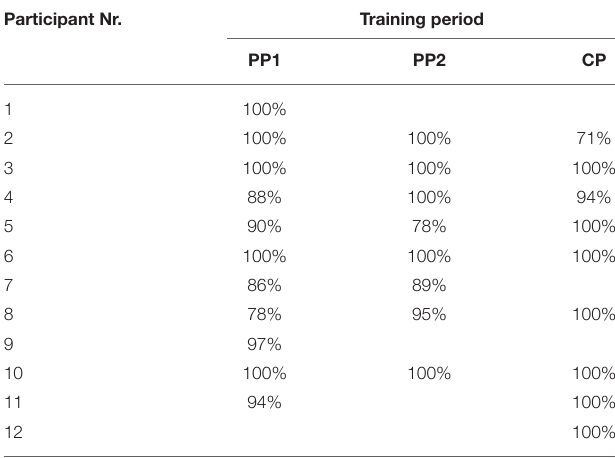
TABLE 2 | The mileage indicated by the GPS watch and included in data analysis as a percentage of the mileage reported in the online diary by each individual athlete for each training